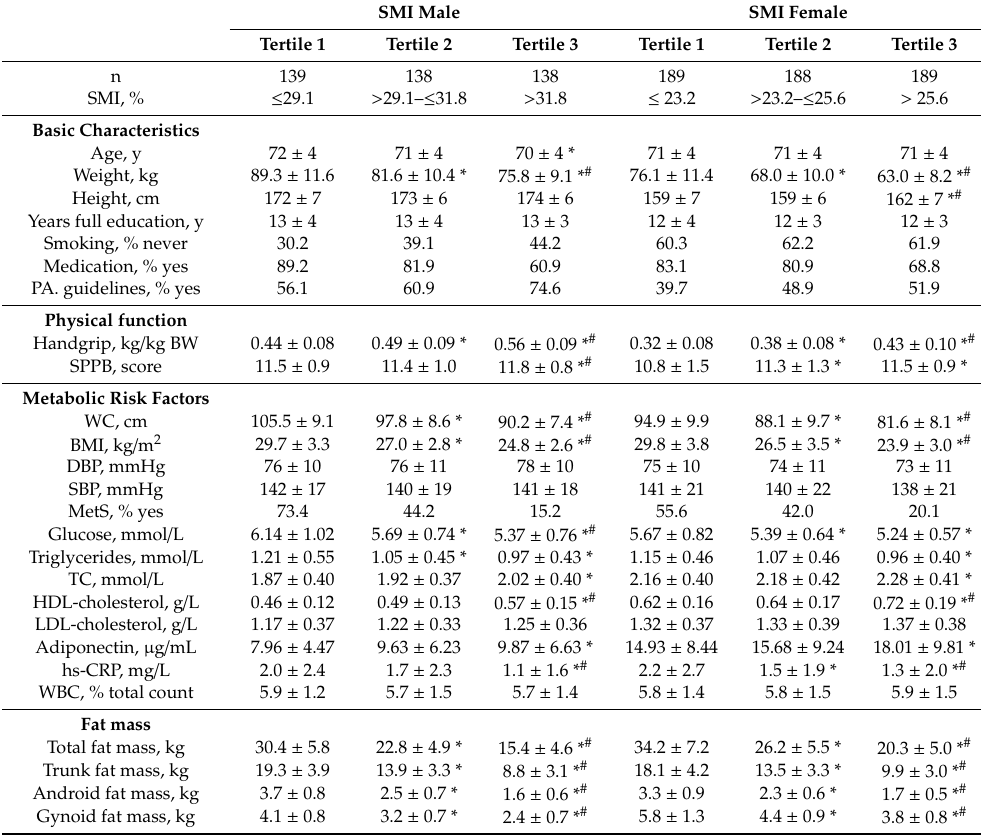
Table 1. Characteristics of the study sample according to sex-specific tertiles of skeletal muscle mass index (SMI).